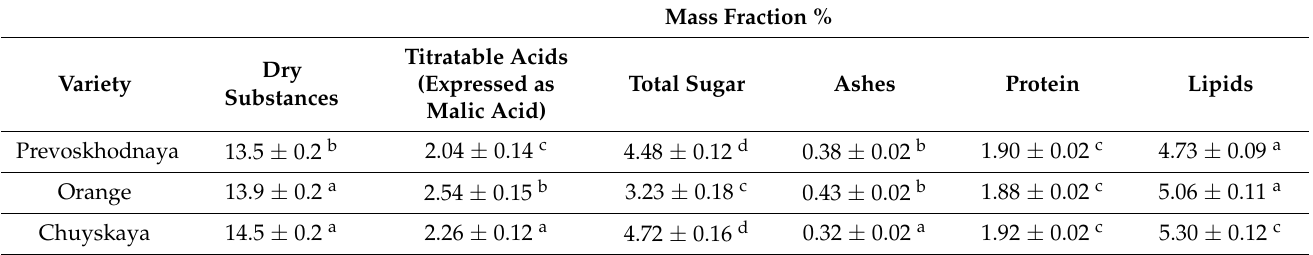
Table 1. Chemical composition of sea buckthorn fruits. Mass Fraction %